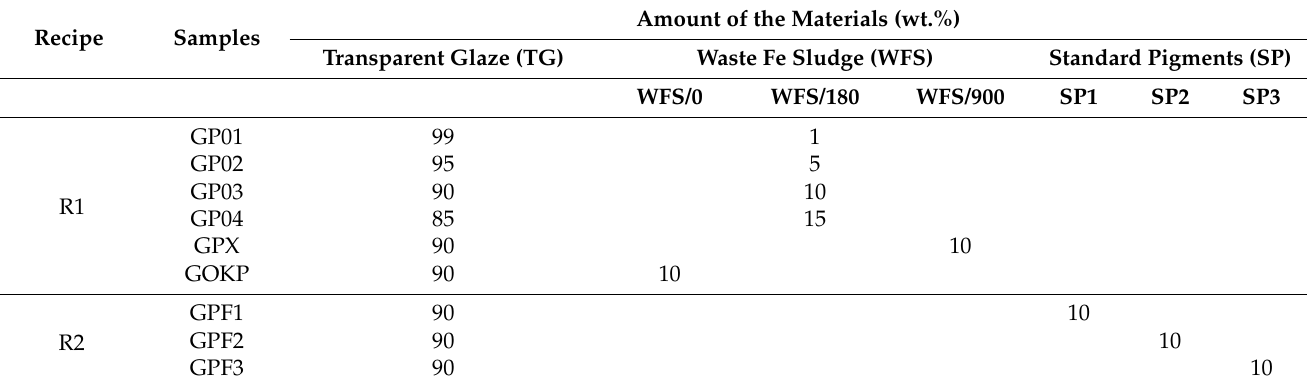
Table 2. Chemical composition of materials.